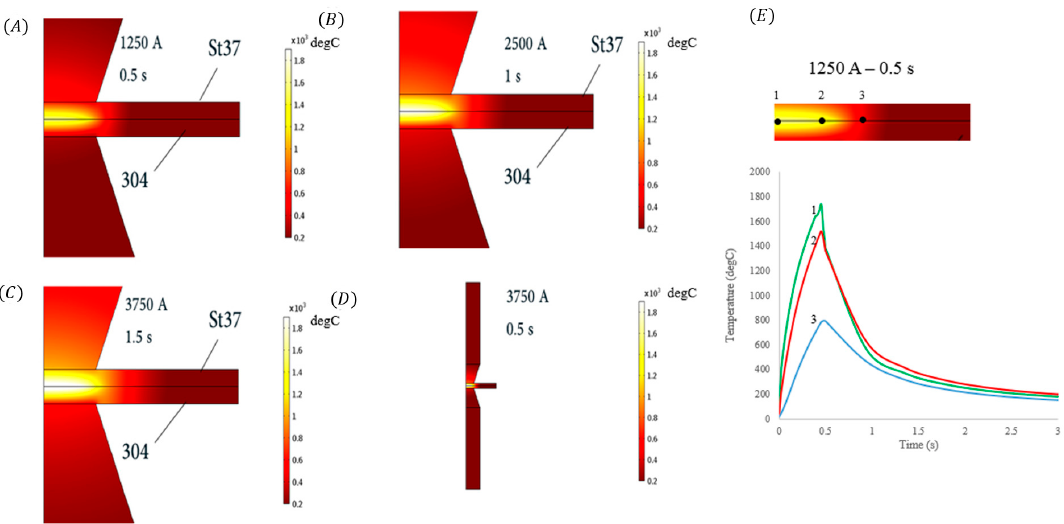
Figure 5. Simulation results of temperature distribution in the weld zone, ( a ) 1250 A and 0.5 s, ( b ) 2500 A and 1 s, ( c ) 3750 and 1.5 s, ( d ) electrodes 1250 A and 0.5 s and ( e ) is the thermal history diagram of three points in the weld zone and HAZ of 1250 A and 0.5 s specimen.